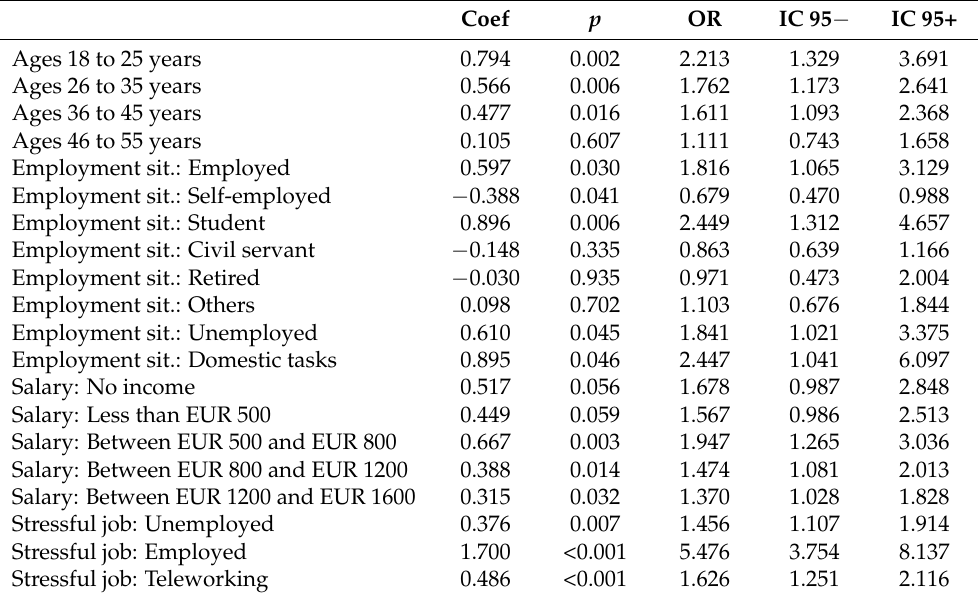
Table 1. Factors associated with the presence of state anxiety.